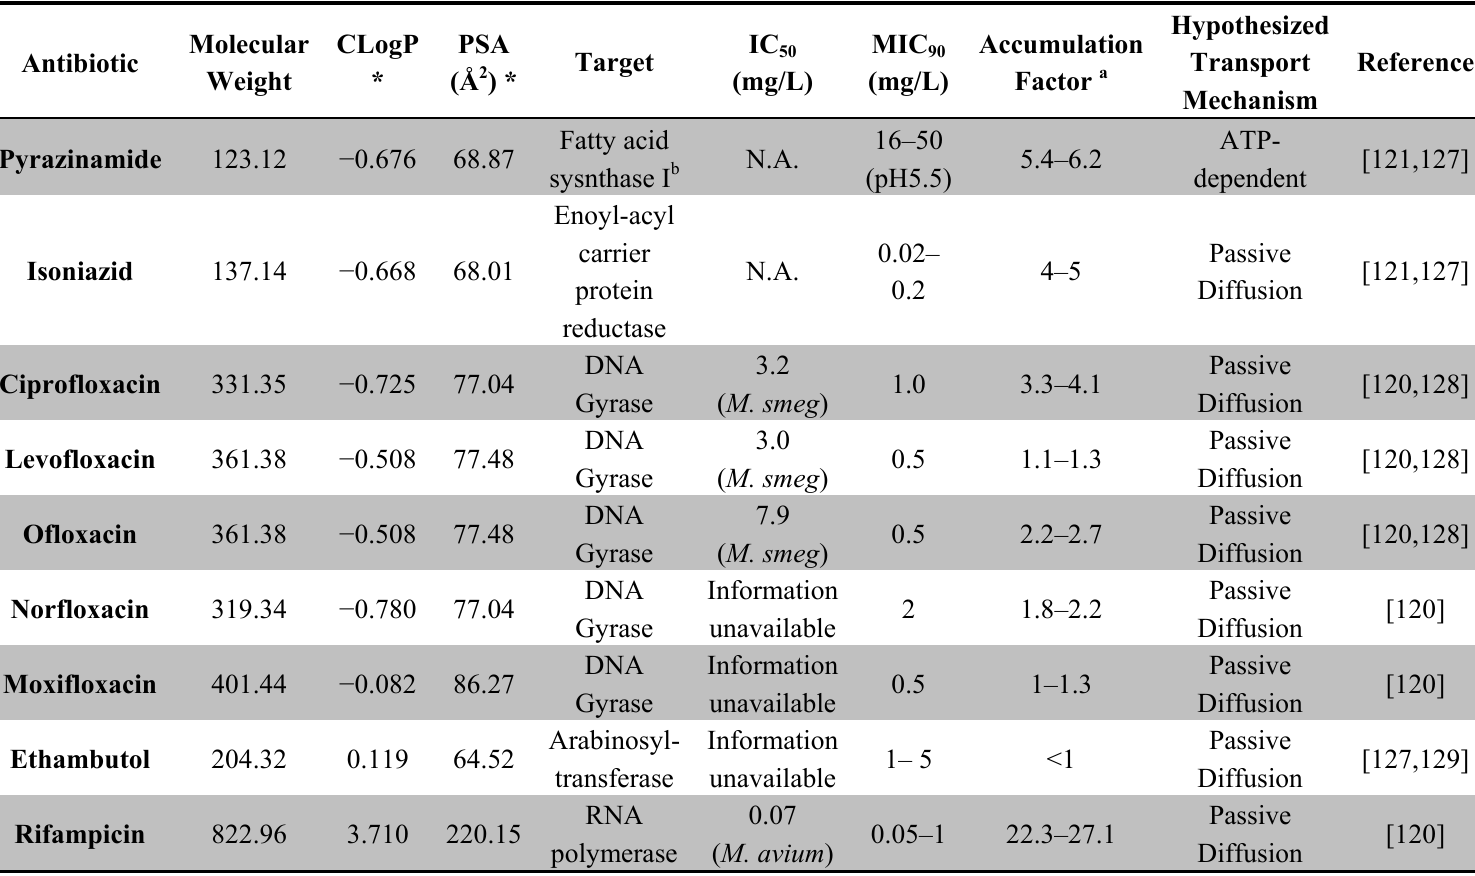
Table 4. Physico-chemical properties and intracellular accumulation factors of several antibiotics in M. tuberculosis as previously reported in published literature. Intracellular accumulation factors were defined as the ratio between intracellular and extracellular drug concentrations. Mechanisms of drug uptake were quoted or inferred from referenced